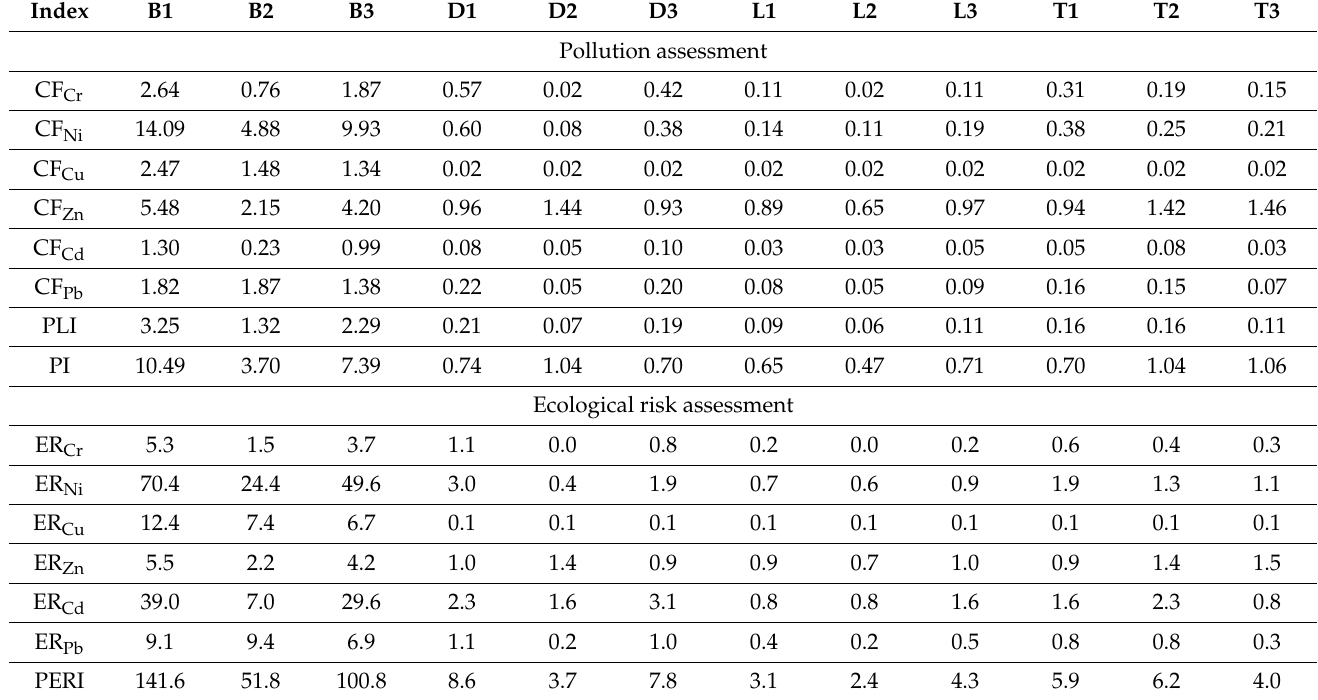
Table 1. State of river sediment contamination according to Cd, Cu Cr, Ni, Pb, and Zn and potential ecotoxicological